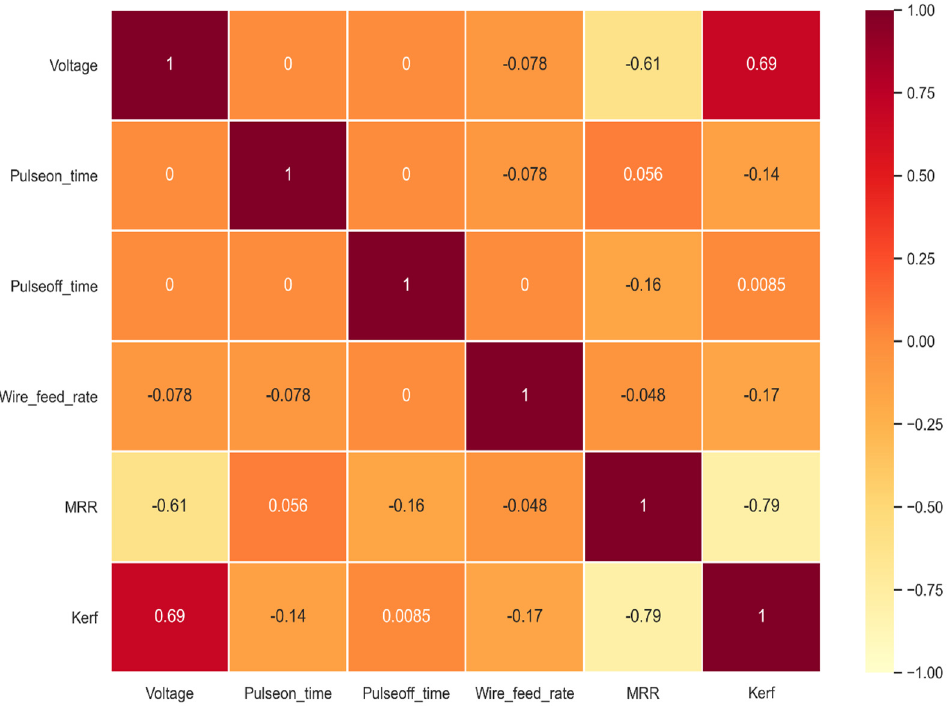
Figure 9. Experimental versus random forest regression predicted ( a ) MRR ( b ) Kerf. Figure 10. Residuals versus random forest regression predicted ( a ) MRR ( b ) Kerf.